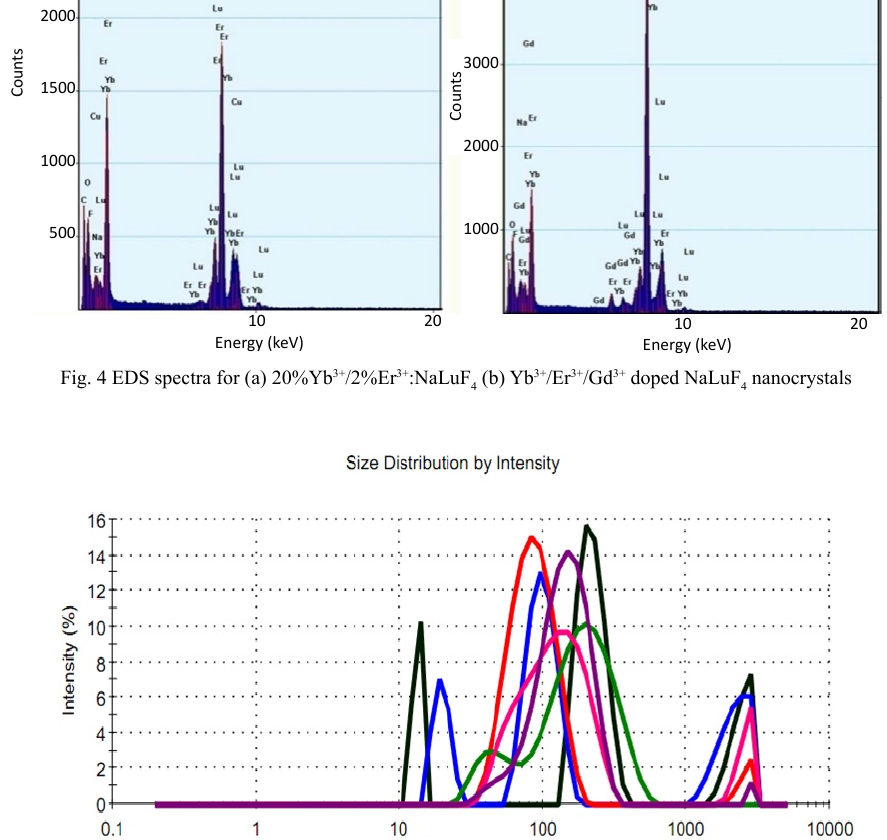
nanocrystals with 4